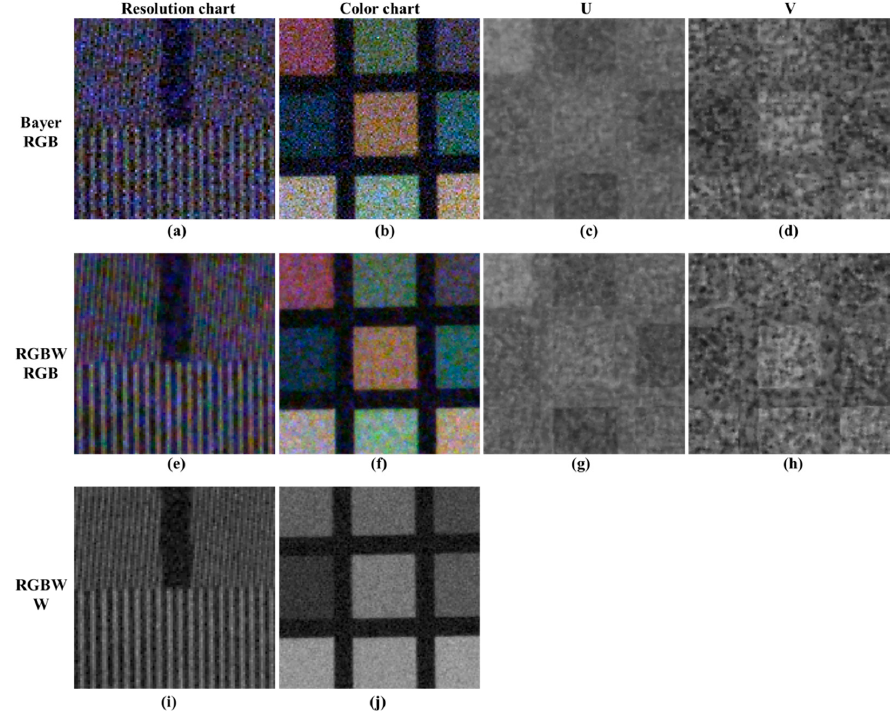
Figure 4. Results of Bayer CFA and RGBW CFA demosaicing in low light conditions: ( a – d ) Bayer CFA demosaicing results [19]; ( e – h ) RGB channels of Sony RGBW CFA demosaicing results [24]; ( i , j ) W channel of Sony RGBW CFA demosaicing results [24]. Table 1. Characteristics of red-green-blue (RGB) and white (W) channels. (o means include, x means not include) Characteristics RGB W